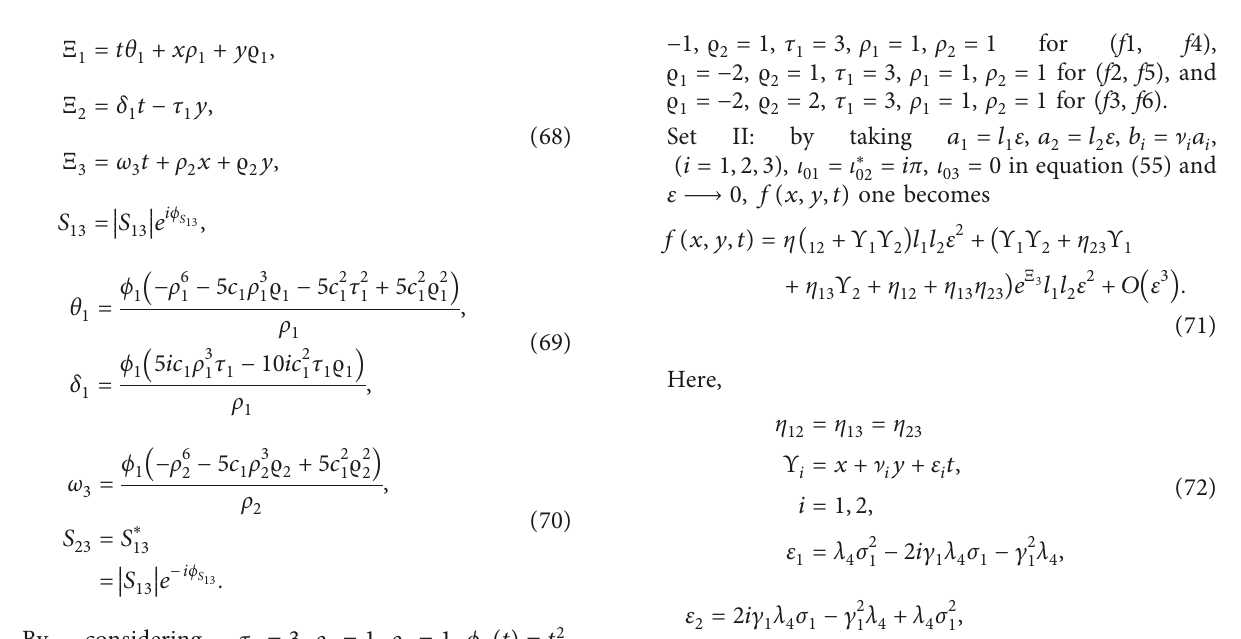
� 2 , ϕ ( t ) � 1 , ϕ ( t ) � cos ( t + 3 ) , c 1 1 9